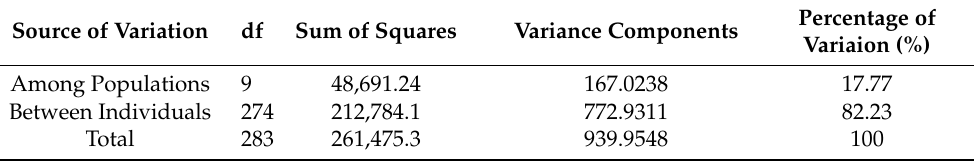
Table 5. Analysis of molecular variance of the ten Chosenia arbutifolia provenances.